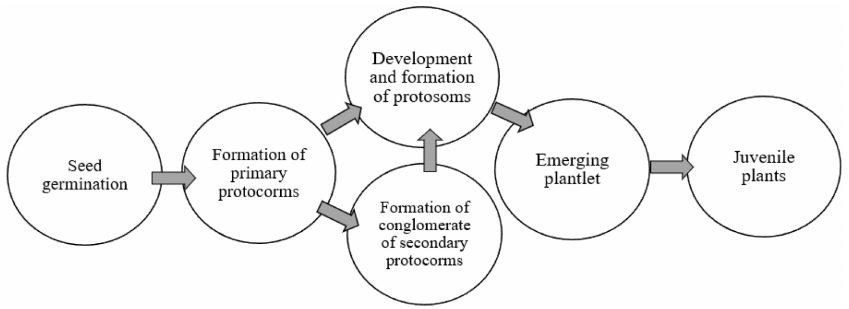
Figure 1. Asymbiotic seed germination of orchid in vitro (author M.